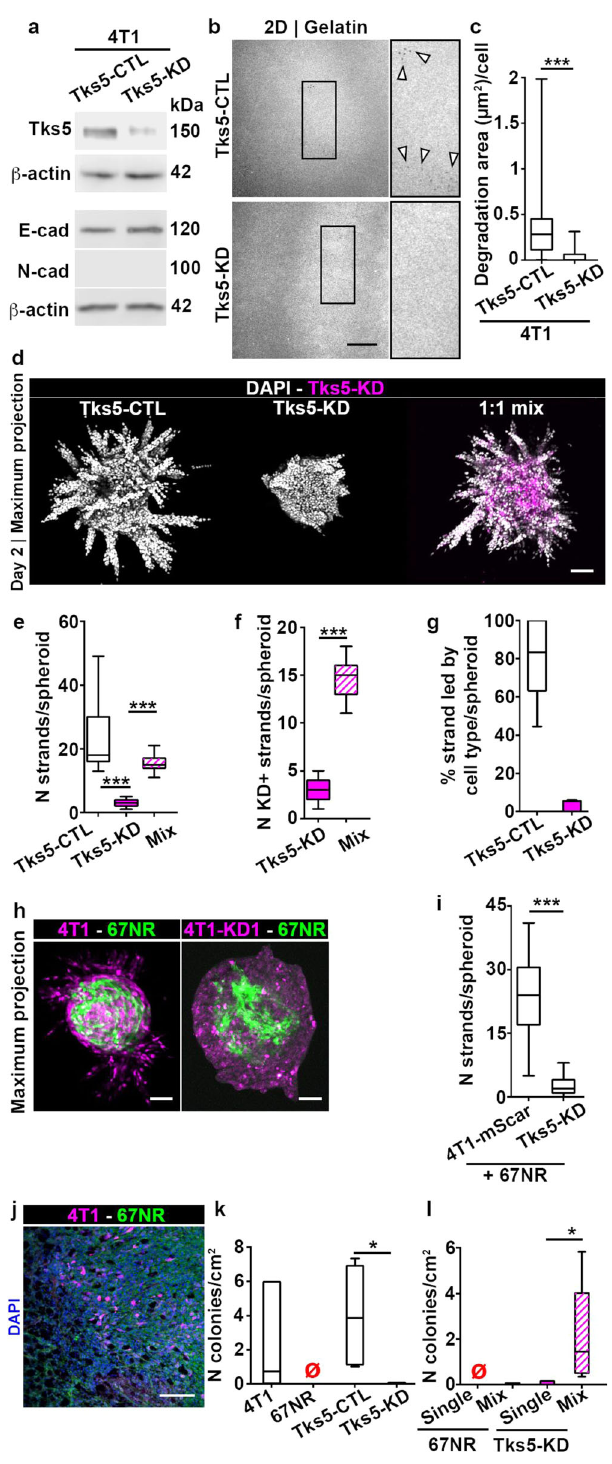
Cells with invadopodia lead cells without invadopodia in tion is required for cooperative invasion (Figs. 4 and S6), and that whether speci fi cally invadopodia assembly by 4T1 cells was responsible for ECM degradation. To rigorously con fi rm that invadopodia function is required for cooperative invasion of cancer cells, we stably eliminated invadopodia in 4T1-mScarlet cells, using a knockdown of mouse Tks5 (Tks5-KD) 13 , and